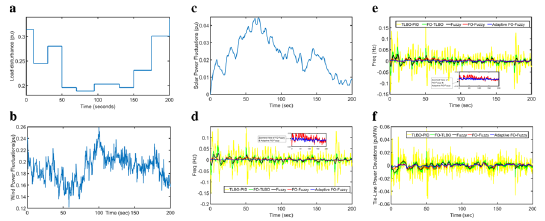
Fig. 11 a Load profile b Wind farm power deviations c solar power deviations; frequency deviation response of d area 1, e area 2, f Tie-line power flow deviation